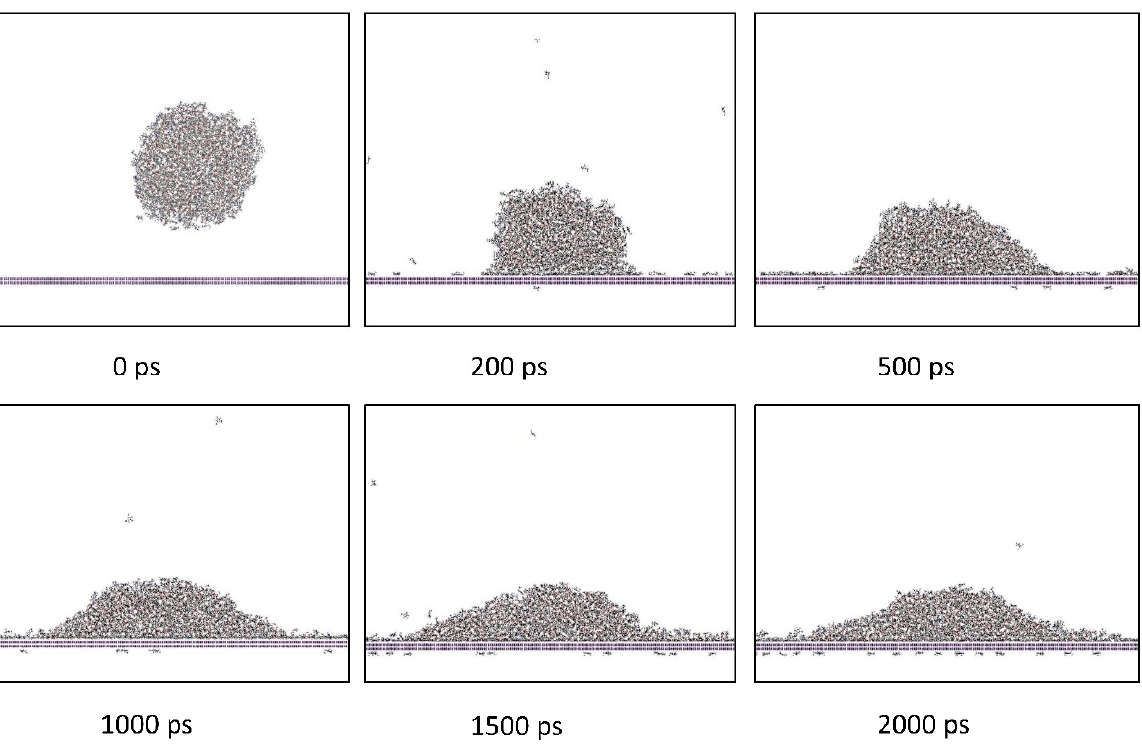
Figure 12. Snapshots of a contact simulation for a representative difunctional epoxy system on an aromatic surface at 147 °C.